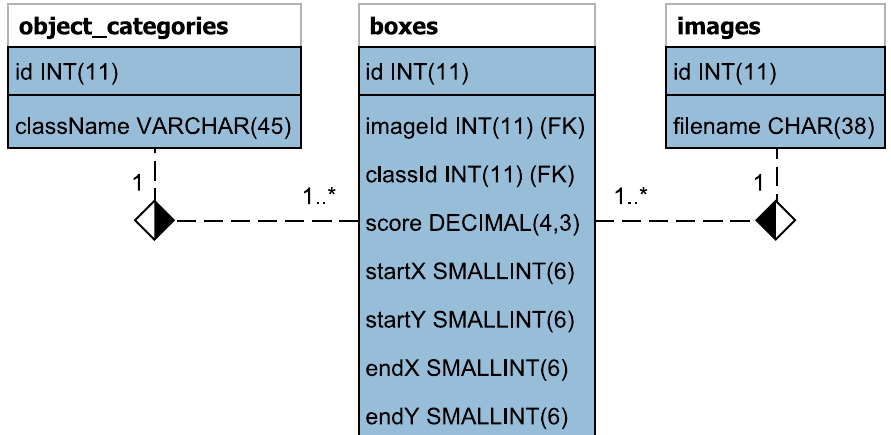
Figure 4. Database scheme for storing objects and bounding boxes within every image of the proposed LSUN-Stanford car